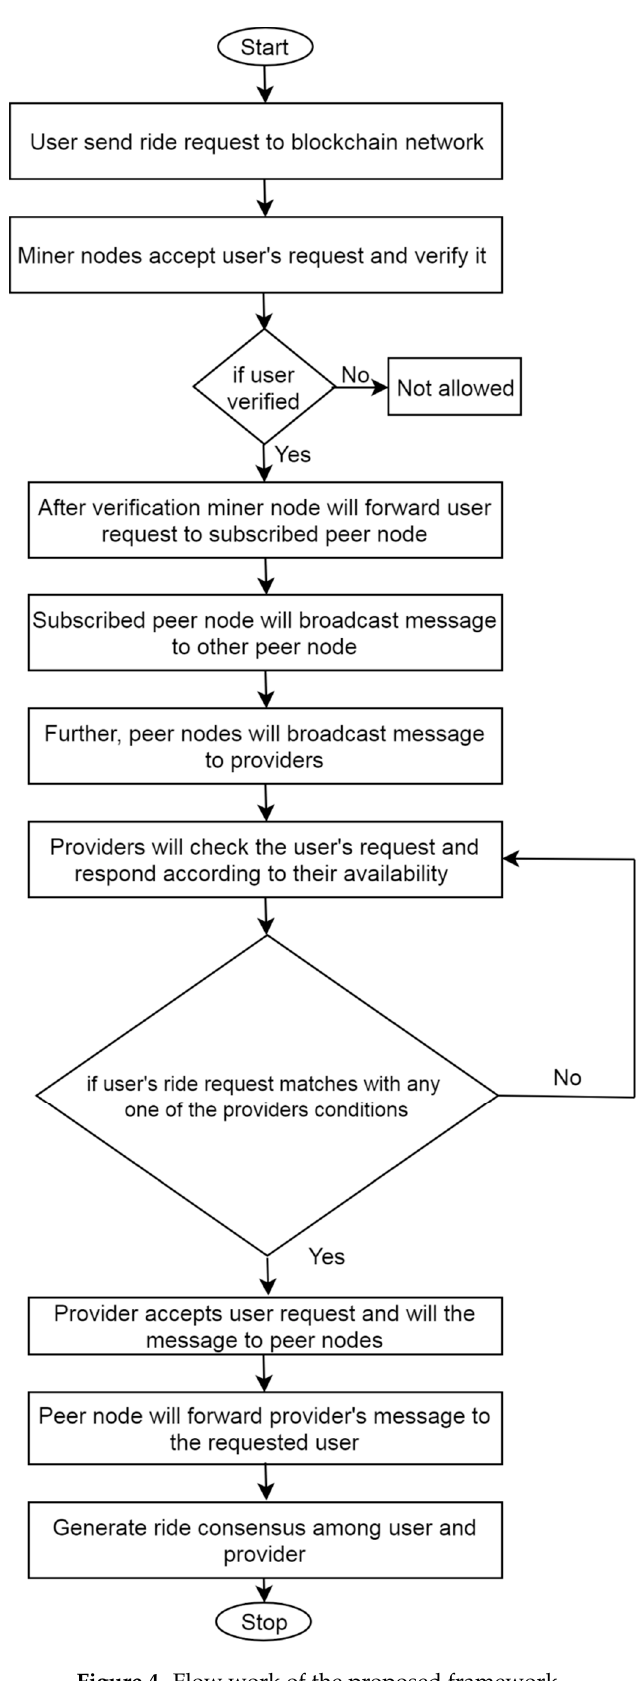
Figure 4. Flow work of the proposed framework.